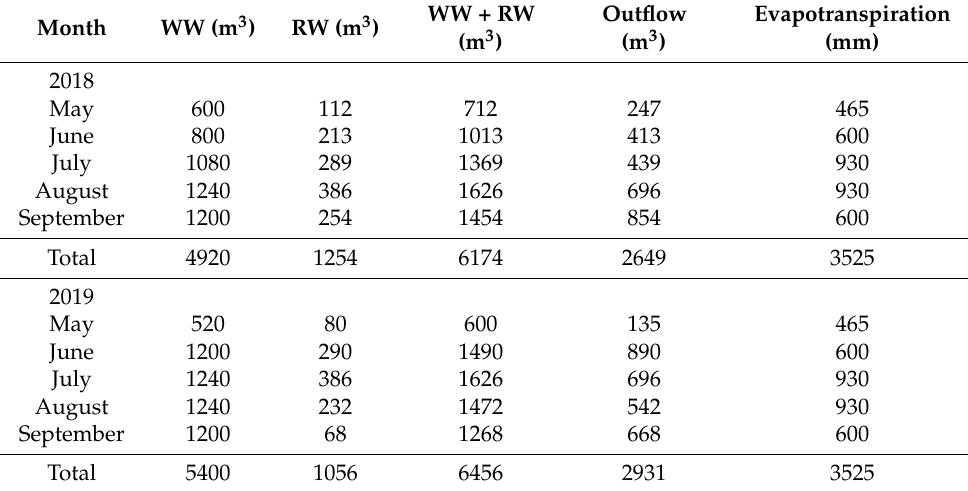
Table 1. The flow/outflow of the processed wastewater (WW) to the field. Rainwater (RW) and evapotranspiration were observed during the 2018 and 2019 growing periods.